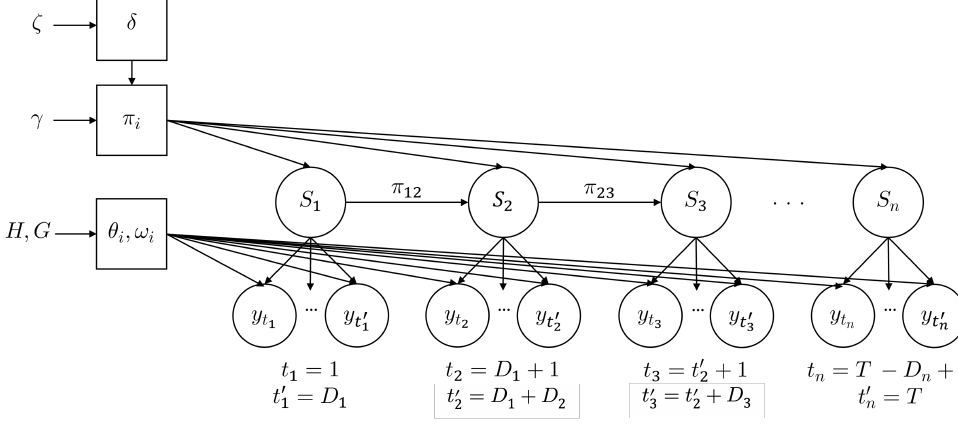
Figure 1. The hidden semi-Markov model. Each state S i contains a D i number of observations y . The state transitions are modelled by the transition probabilities π i , j . T denotes the total observation time. The rest of the notation is explained in the main text.